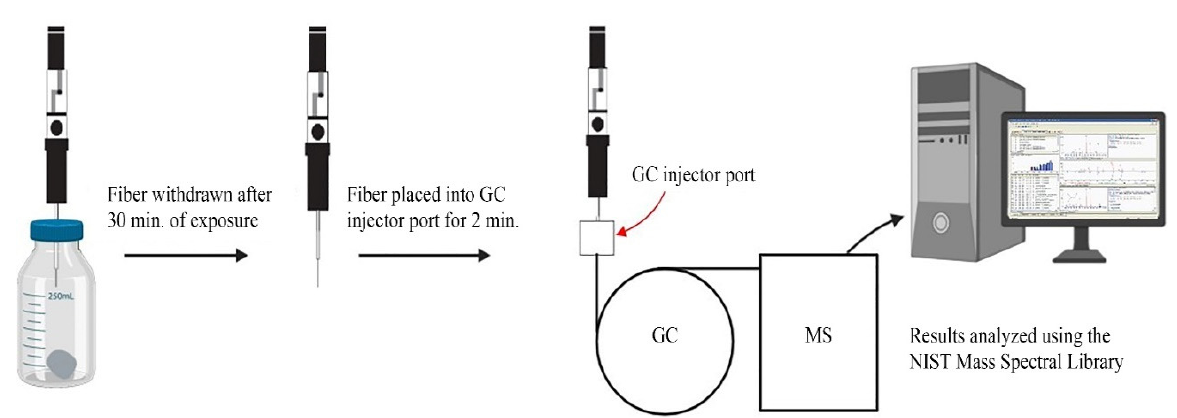
Figure 2. Experimental setup for analyzing the embedded toxicity of recycled wood and concrete. Samples are incubated at 70 °C for 24 h in 250 mL DURAN ® BlueCap flasks with septum caps. After the incubation, the solid-phase microextraction (SPME) fiber is exposed to the gaseous phase inside the flask for 30 min before being injected into the gas chromatography (GC) injector port for 2 min desorption at 230 °C. The injected sample runs through the gas chromatography-mass spectrometry (GC-MS) instrument for 60 min to separate, detect, and analyze the sample giving a full CG-MS chromatogram with the substances in the sample. The substances emitted from each sample can be qualitatively identified using the Xcalibur Qual Browser and the National Institute of Standards and Technology (NIST) Mass Spectral Library. Table 1. VOCs were identified from the contamination test of the SPME fiber and the GC-MS column itself, as well as the blank samples. The compound is identified with a CAS number (CAS no.) from the National Institute of Standards and Technology (NIST) library. However, a CAS no. was not available (N/A) for the various types of cyclosiloxane. Compound CAS